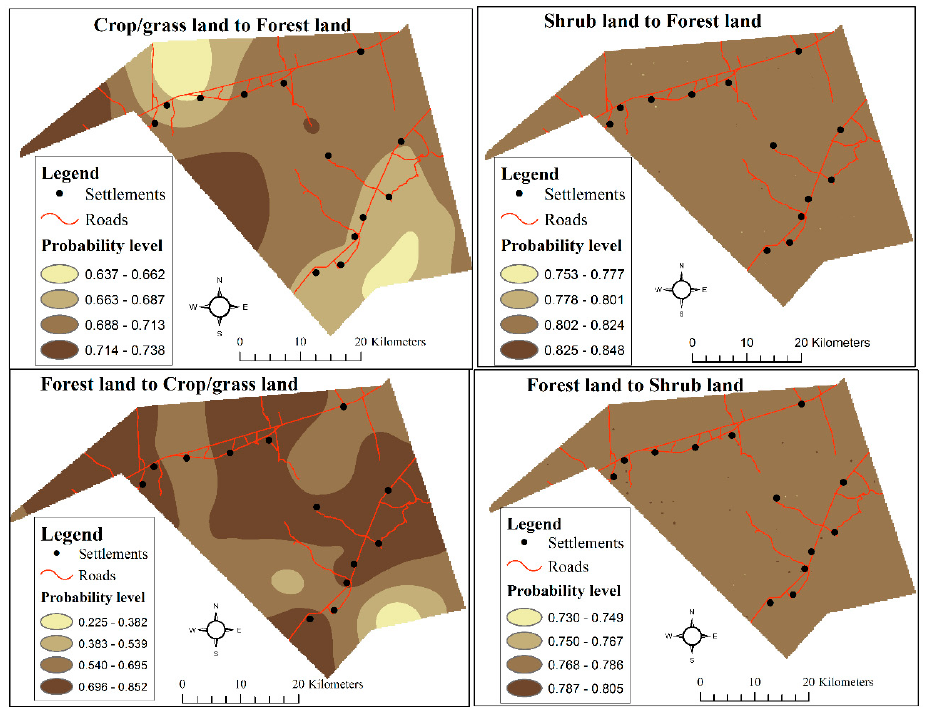
Figure 5. Probability of occurrence for the selected LULC conversions in the communal area.